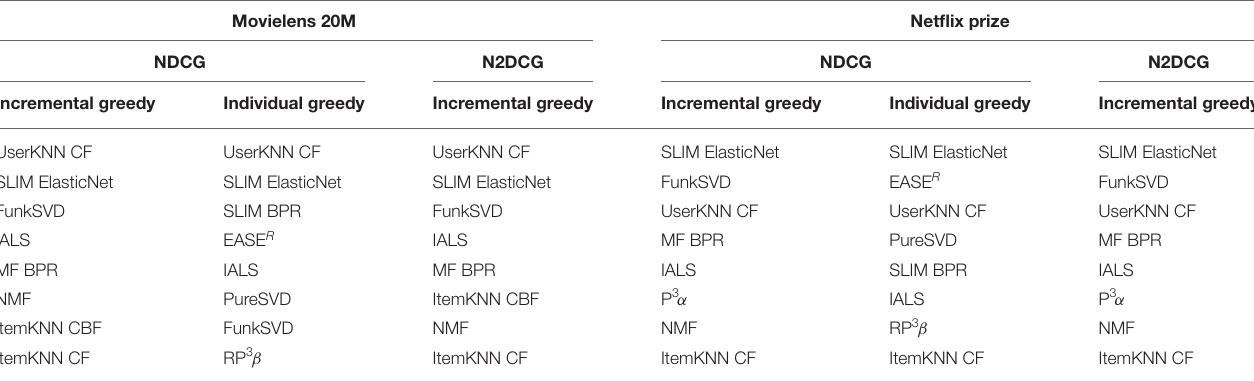
TABLE 7 | Layouts of 8 carousels selected for the Movielens 20M and Netflix Prize datasets selected according to different strategies and optimizing both the single list NDCG and the proposed two-dimensional